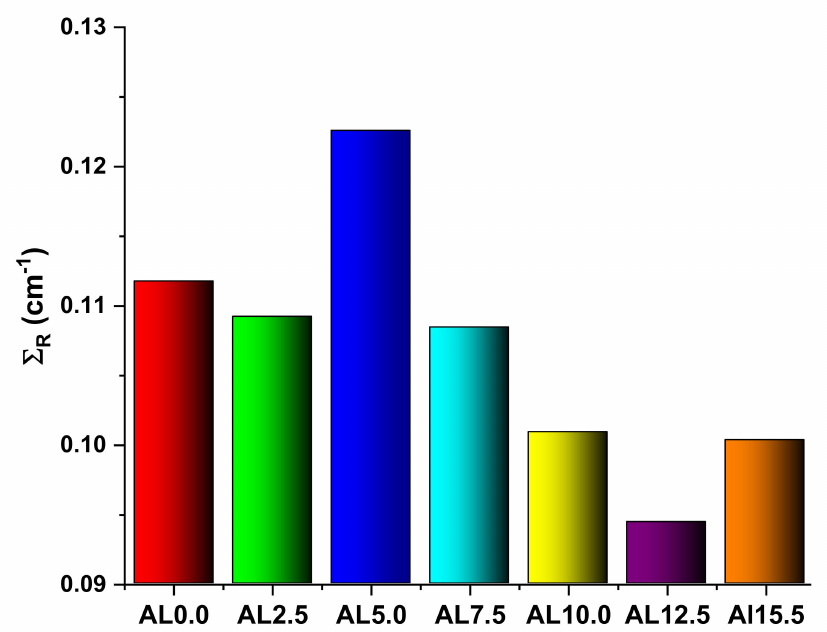
Figure 12. Effective removal cross-sections for fast neutrons ( Σ R ) for all